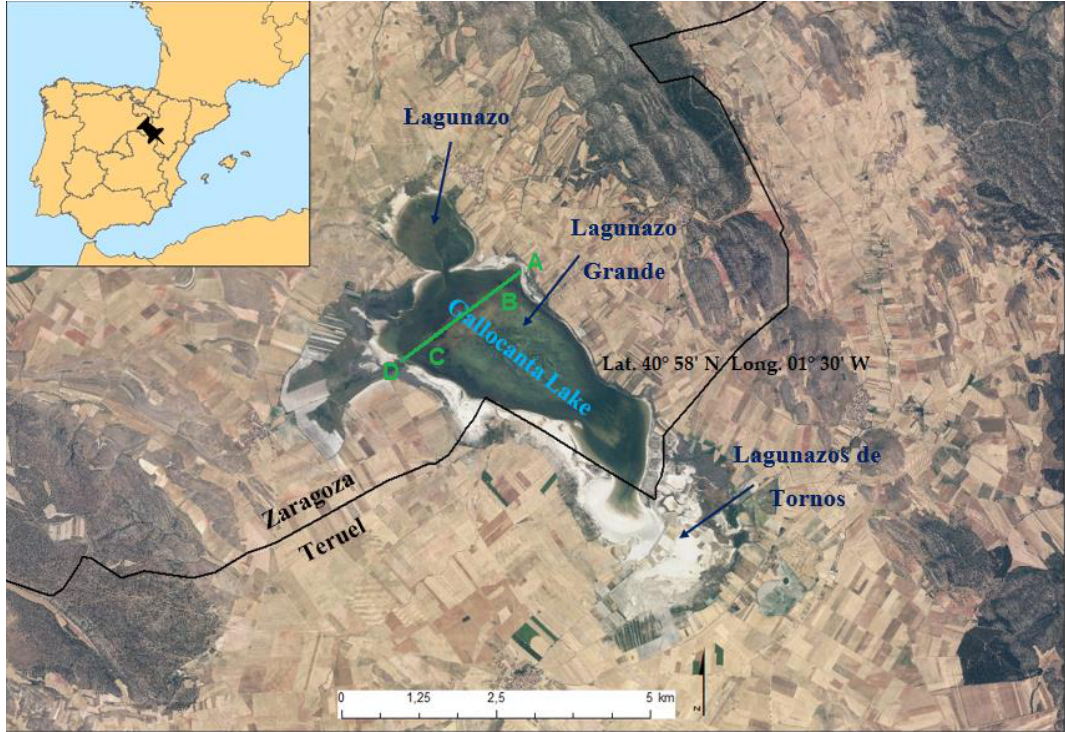
Figure 1. Location map of Gallocanta Lake (elaborated from the 2019 image of the National Plan of Air Orthophotograph of the National Geographical Institute of Spain). Geographical coordinates of the center of the lake. Green line A – D indicates vegetation study.